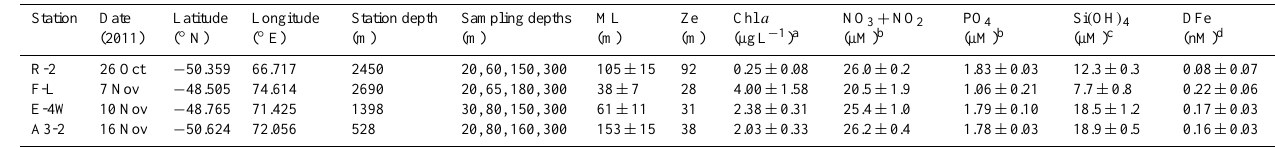
Table 1. Brief description of the stations. The depth of the mixed layer (ML) is based on a difference in sigma of 0.02 to the surface value. The mean ML ( ± SD) of all CTD casts performed during the occupation of the stations is given. Ze: the euphotic layer depth. For Chl a and major inorganic nutrients mean values ± SD for the mixed